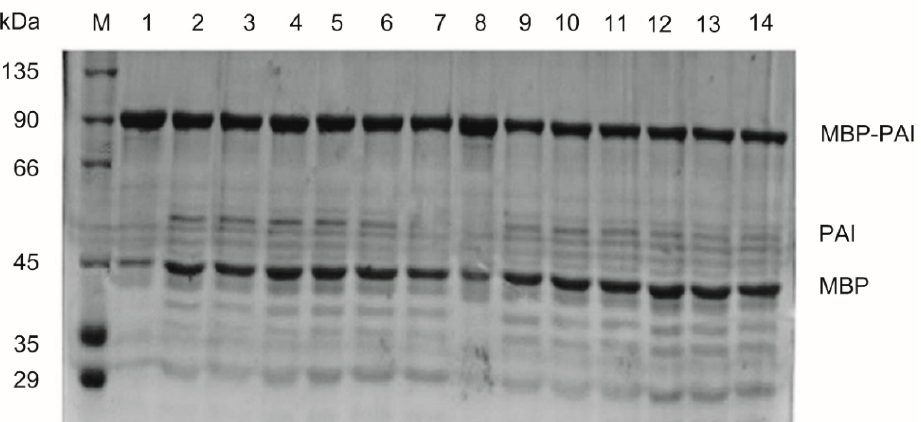
Figure 6. Detection of purified MBP-PAI before cleavage and MBP and PAI after cleavage by Factor Xa. M: marker; Lanes 1 and 8: purified MBP-PAI; lanes 2~7: treated with 1%, 1.5%, 2%, 3%, 4%, and 5% Factor Xa and 0.05% SDS for 12 h; Lanes 9~14: treated with 1%, 1.5%, 2%, 3%, and 4% Factor Xa and 0.05% SDS for 24 h.